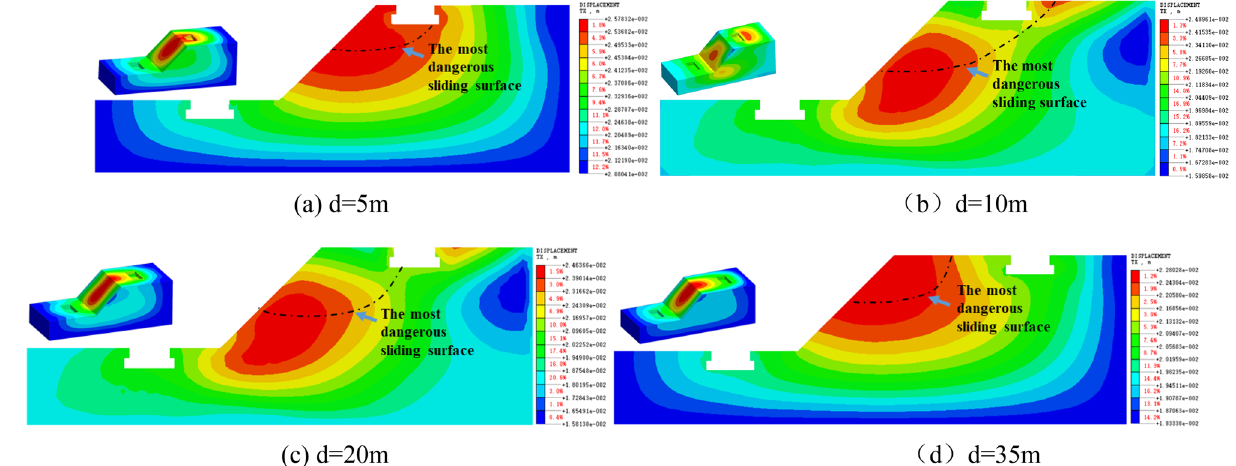
Figure 8. Horizontal displacement nephogram of models with H = 30 m, α = 45°.